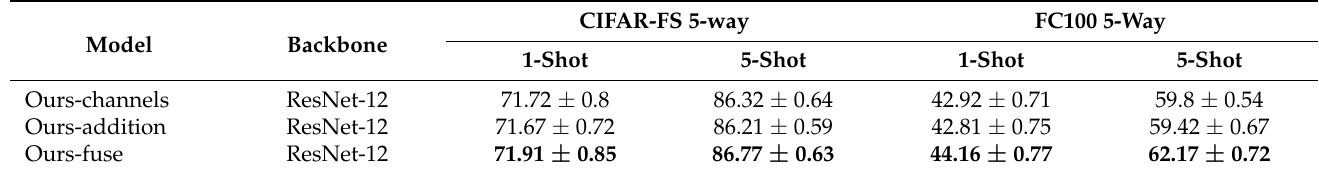
Table 5. Comparison of different feature fusion methods on CIFAR-FS and FC100. “Ours-channels” denotes fusing features directly by the same size of channels. “Ours-addition” denotes summing features from different stages and feeding them to other stages. Average meta-learning classification accuracies (%) with 95% confidence intervals on CIFAR-FS and FC100.